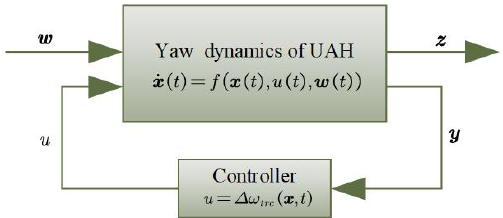
Figure 2. A nonlinear robust yaw controller